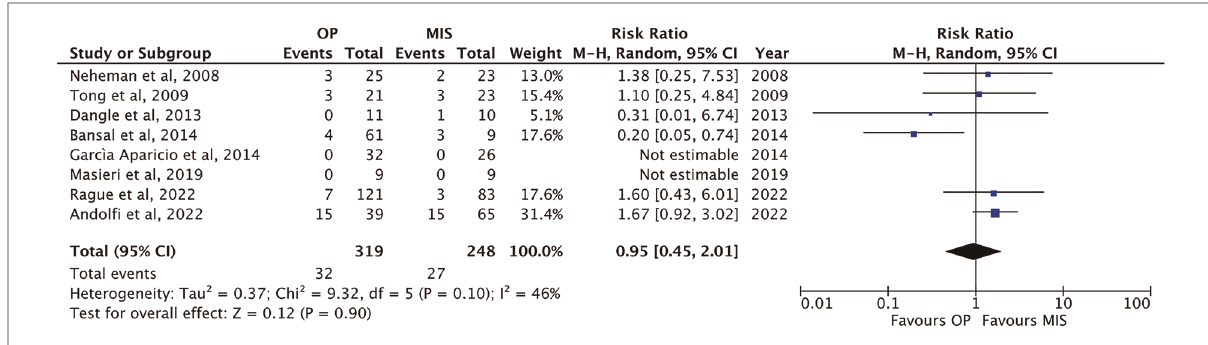
FIGURE 6 Forest plot comparison of the incidence of postoperative complications between OP and MIS in infants .